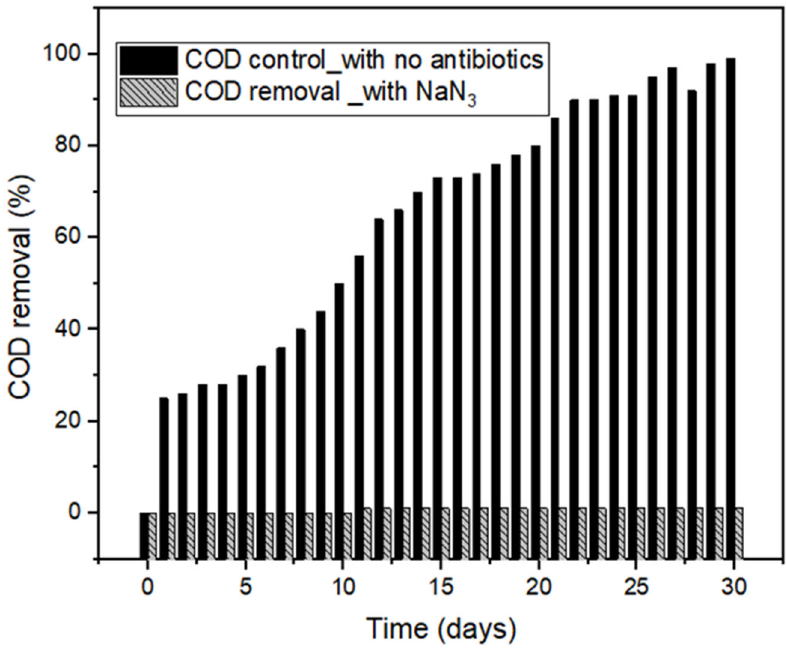
Figure 1. Biodegradation effect on COD removal in control reactors at 35 ◦ C for 30 days 35 ◦ C, pH 7, and OLR at 3.5 kg COD · m − 3 · days − 1 .